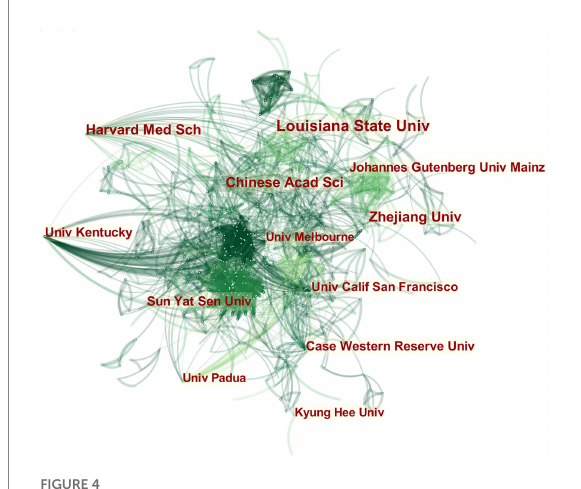
FIGURE 4 The collaboration network of top 12 institutions on MGBA in AD. The size of the nodes in the graph represents the number of publications of the institution, and the thickness of the lines between nodes represents the strength of the relationship. The different colors of nodes and connection lines represent different years (for instance, purple represents 2013–2014, blue-green represents 2017–2018, and yellow represents